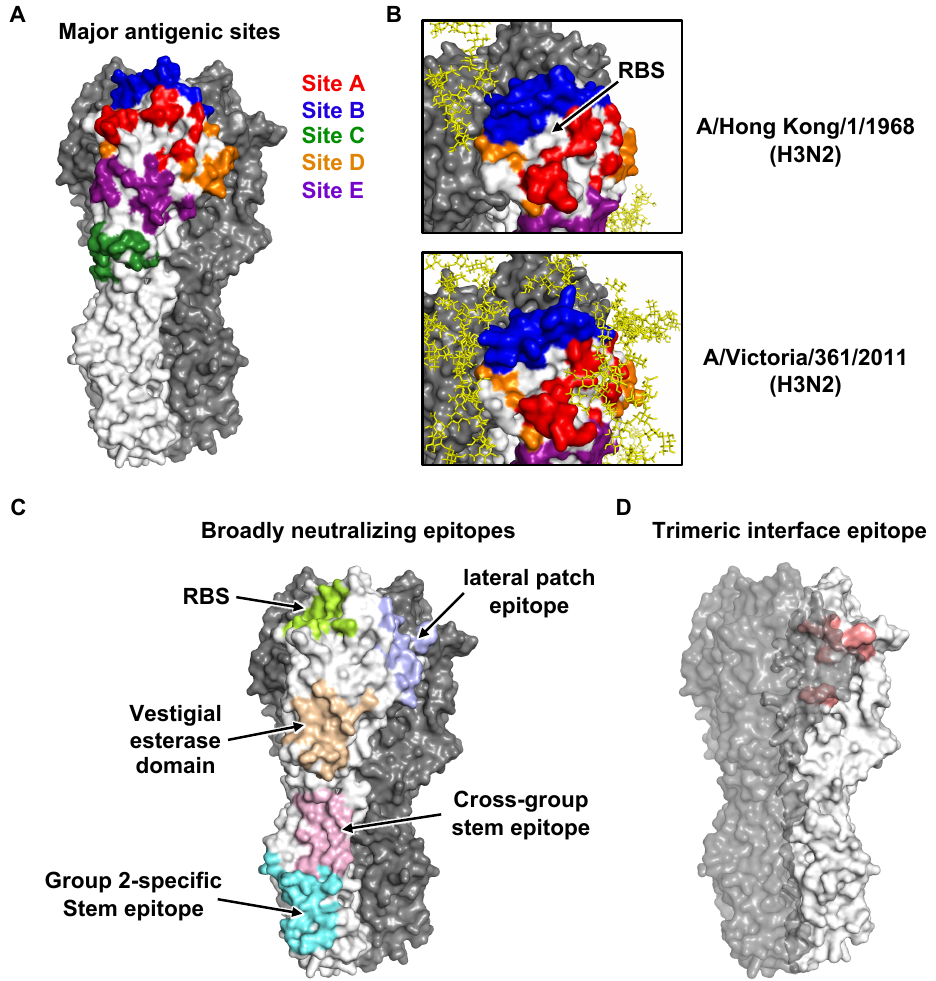
Figure 3. Conventional antigenic sites and recently identified epitopes. ( A ) The five major antigenic sites A-E on H3N2 HA are shown. ( B ) There is an accumulation of glycosylation sites during human H3N2 evolution. While many antigenic sites have now been masked by glycans (yellow), antigenic site B (blue) remains exposed due to its proximity to the RBS, making it immunodominant in recent human H3N2 strains [95,96]. ( C ) Broadly neutralizing epitopes that have been identified in the past decade are shown. ( D ) A recently identified trimeric interface epitope is